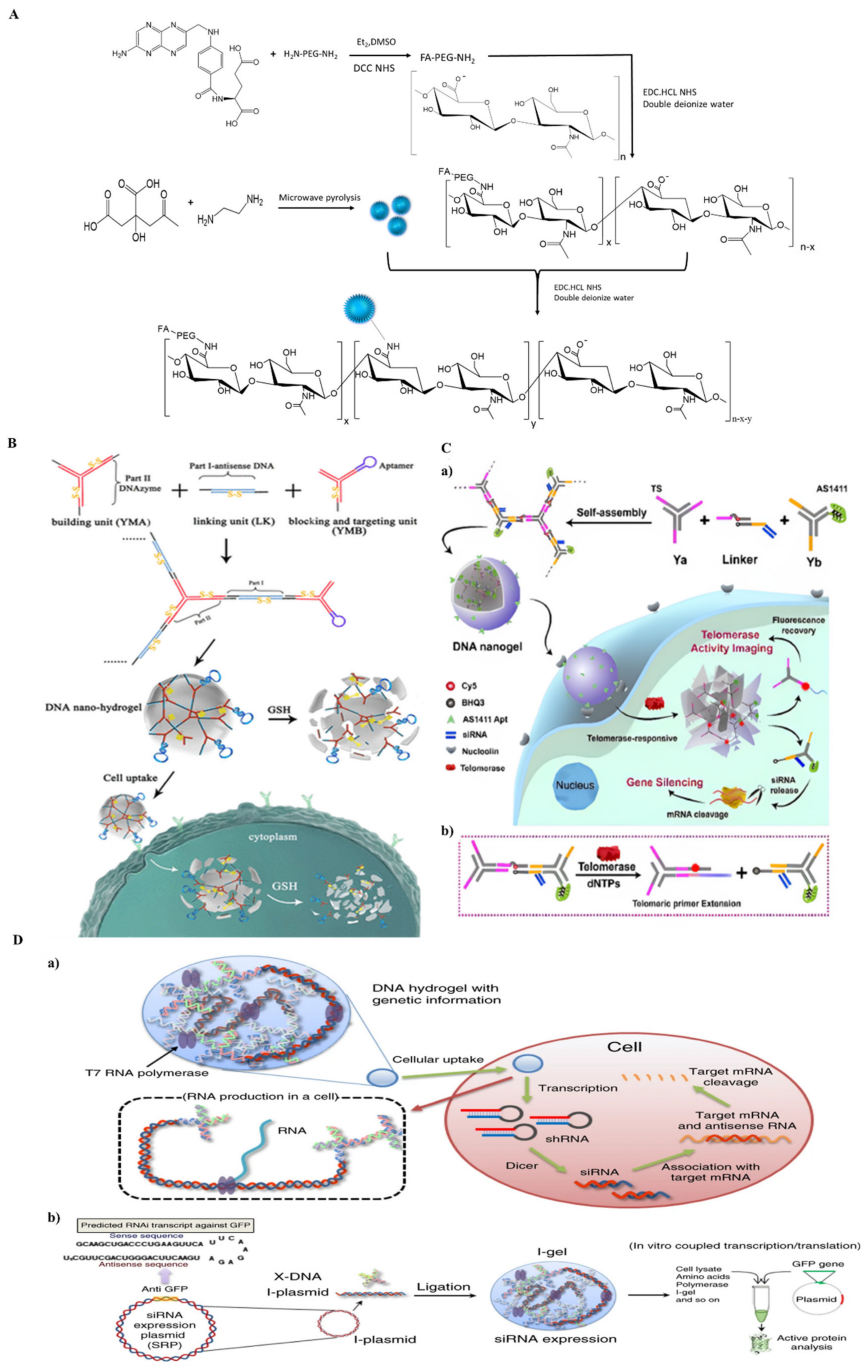
Figure 4. ( A ) Schematic illustration of the formation of PEGHA@CD hybrid nanogels. (Reproduced with permission from ref. [89] Copyright Elsevier 2016.) ( B ) Schematic illustration of